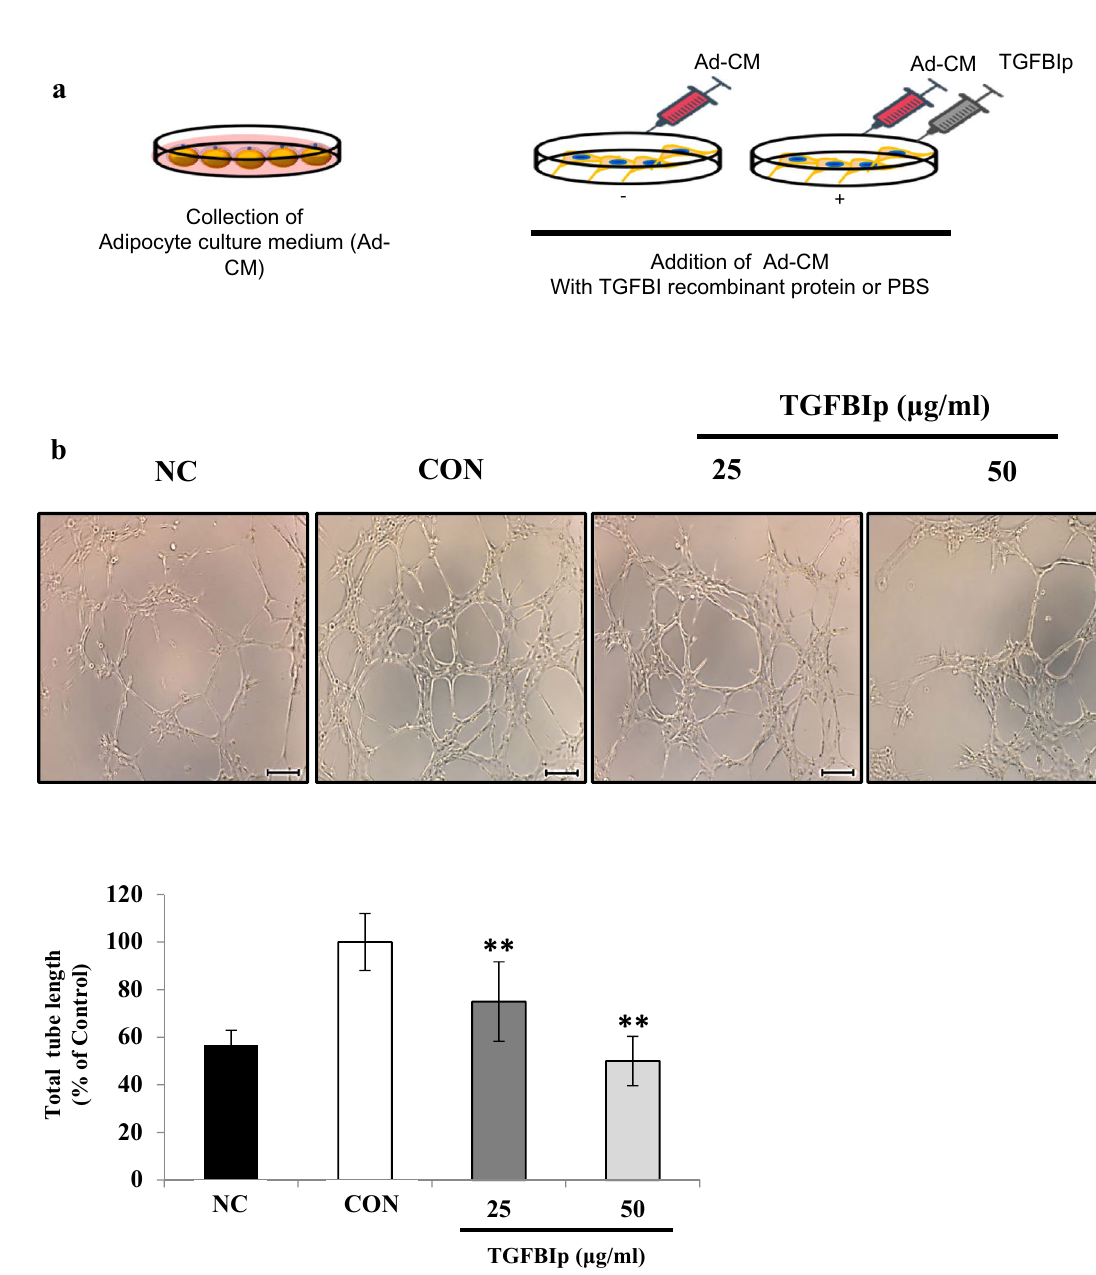
Figure 3. TGFBI reduces the migration and tube formation activity stimulated by Ad-CM in SVEC-10 endothelial cells. (a) Schematic of the in vitro experiment using SVEC-10 cells treated with Ad-CM. Negative control cells (NC) were cultured in normal growth medium with the same amount of PBS. (b) Representative images of tube formation (upper) and quantitation of the total tube length (lower). Scale bars represent 200 μm. (c) Representative images of migration (upper) and quantitation of the migrated cells after staining with crystal violet (lower). (d) SVEC-10 cells were starved overnight, treated with TGFBI for 60 min, and then stimulated with adipocyte-CM for 10 min. Expression levels of the indicated proteins were quantified (right). Data are presented as the mean ± s.e.m. *p < 0.05, **p < 0.01 versus